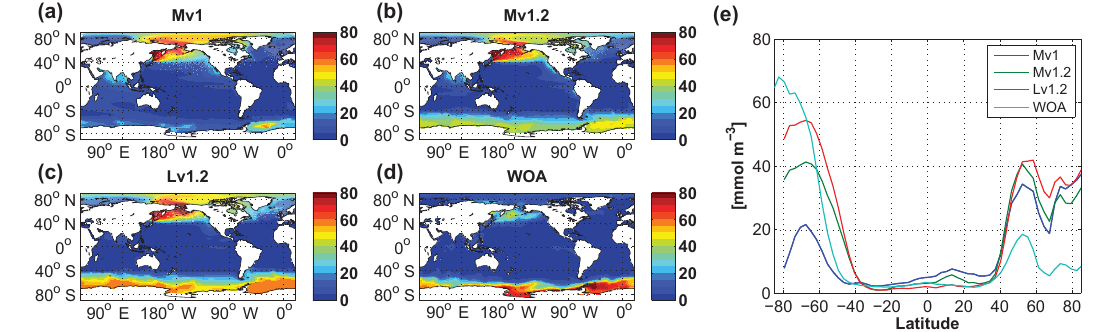
Figure 14. As Fig. 10 but for surface silicate concentrations (mmolm − 3 ).